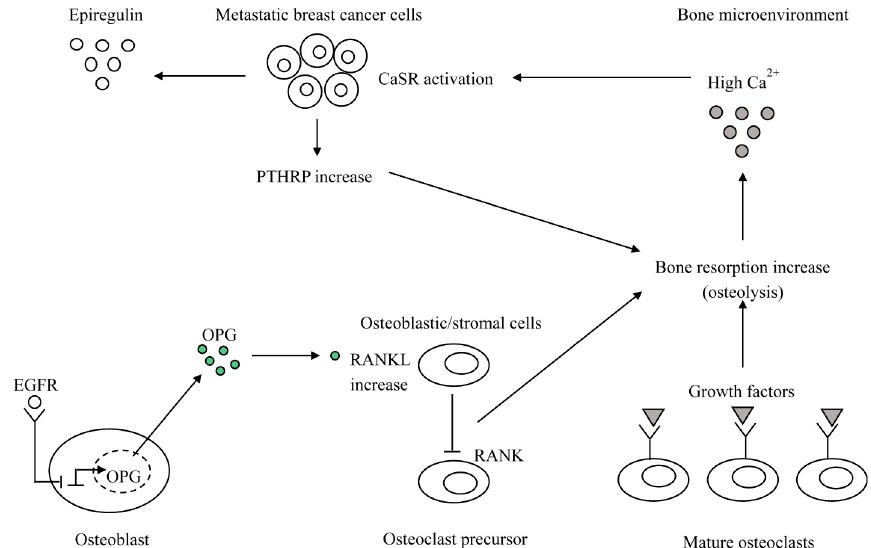
Figure 2. The vicious cycle of bone metastasis and the CaSR-epiregulin axis. At the metastatic bone microenvironment, the elevated Ca 2+ levels activated CaSR in metastatic breast cancer cells stimulate PTHRP secretion that stimulates osteoblasts (Ob) to produce more RANKL thus driving more osteolysis and release of growth factors (GF) from the bone matrix. As a result, a feed forward vicious cycle of bone resorption tumor growth and osteolysis establishes. In addition, CaSR activation induces epiregulin synthesis and secretion. Epiregulin through its receptors expressed by osteoblasts inhibits OPG synthesis, thus favoring interactions between RANKL expressed by osteoblasts and the receptor RANK expressed by immature osteoclasts. This again feeds the vicious cycle (also see text).